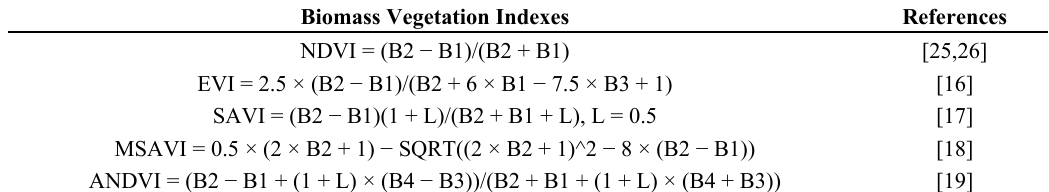
Table 1. Biomass and moisture remote sensing vegetation indexes (bands correspond to the spectral interval of MODIS of Table 2). SAVI, Soil Adjusted Vegetation Index; ANDVI, Adjusted Normalized Difference Vegetation Index; NDII, Normalized Difference Infrared Index; GVMI, Normalized Difference Infrared Index; MSAVI, Modified Soil Adjusted Vegetation